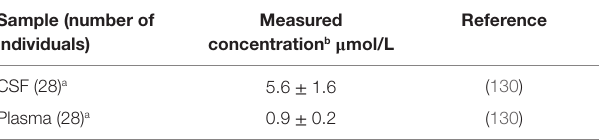
TABLe 5 | Human CSF and plasma cystatin C concentrations. Sample (number of